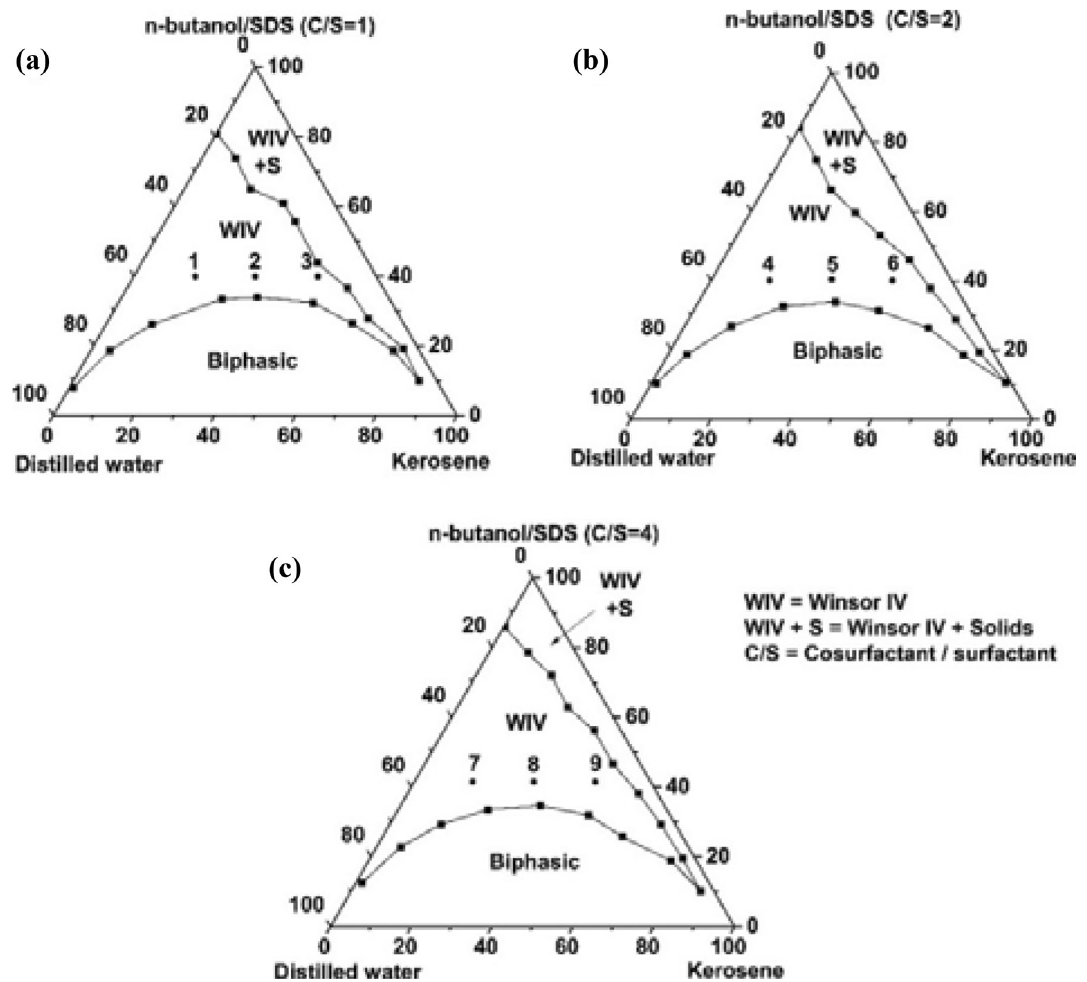
Fig. 1 Pseudoternary diagram varying the C/S ratio in 1 ( a ), 2 ( b ) and 4 ( b )